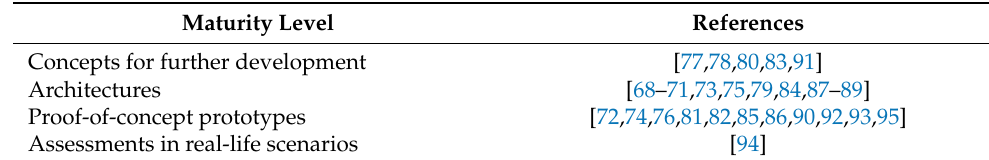
Table 7. Maturity level of the proposed solutions.